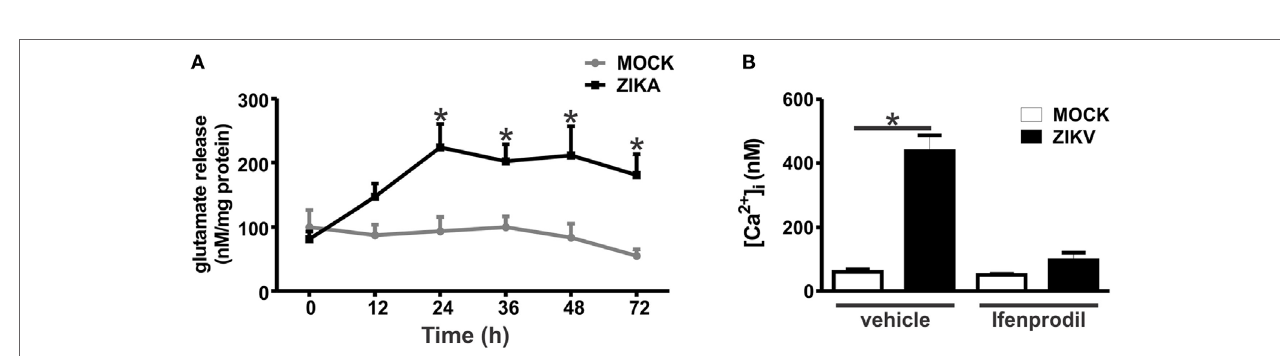
FigUre 4 | Zika virus (ZIKV) infection induces increased levels of extracellular glutamate and augmented Ca 2 + flux through GluN2B-containing N -methyl- d -aspartate receptors. (a) Graph shows a time course of the concentration levels of extracellular glutamate in primary cultured corticostriatal neurons that were either MOCK-infected or infected with ZIKV. Data represent the means ± SEM, n = 6–10. * indicates significant difference as compared to MOCK-infected neurons ( p < 0.05). (B) Graph shows intracellular Ca 2 + concentration ([Ca 2 + ] i ) levels in primary cultured corticostriatal neurons that were either untreated (vehicle) or treated with 0.01 µM ifenprodil for 48 h following MOCK or ZIKV infection. Data represent the means ± SEM, n = 4–8. * indicates significant difference ( p < 0.05).